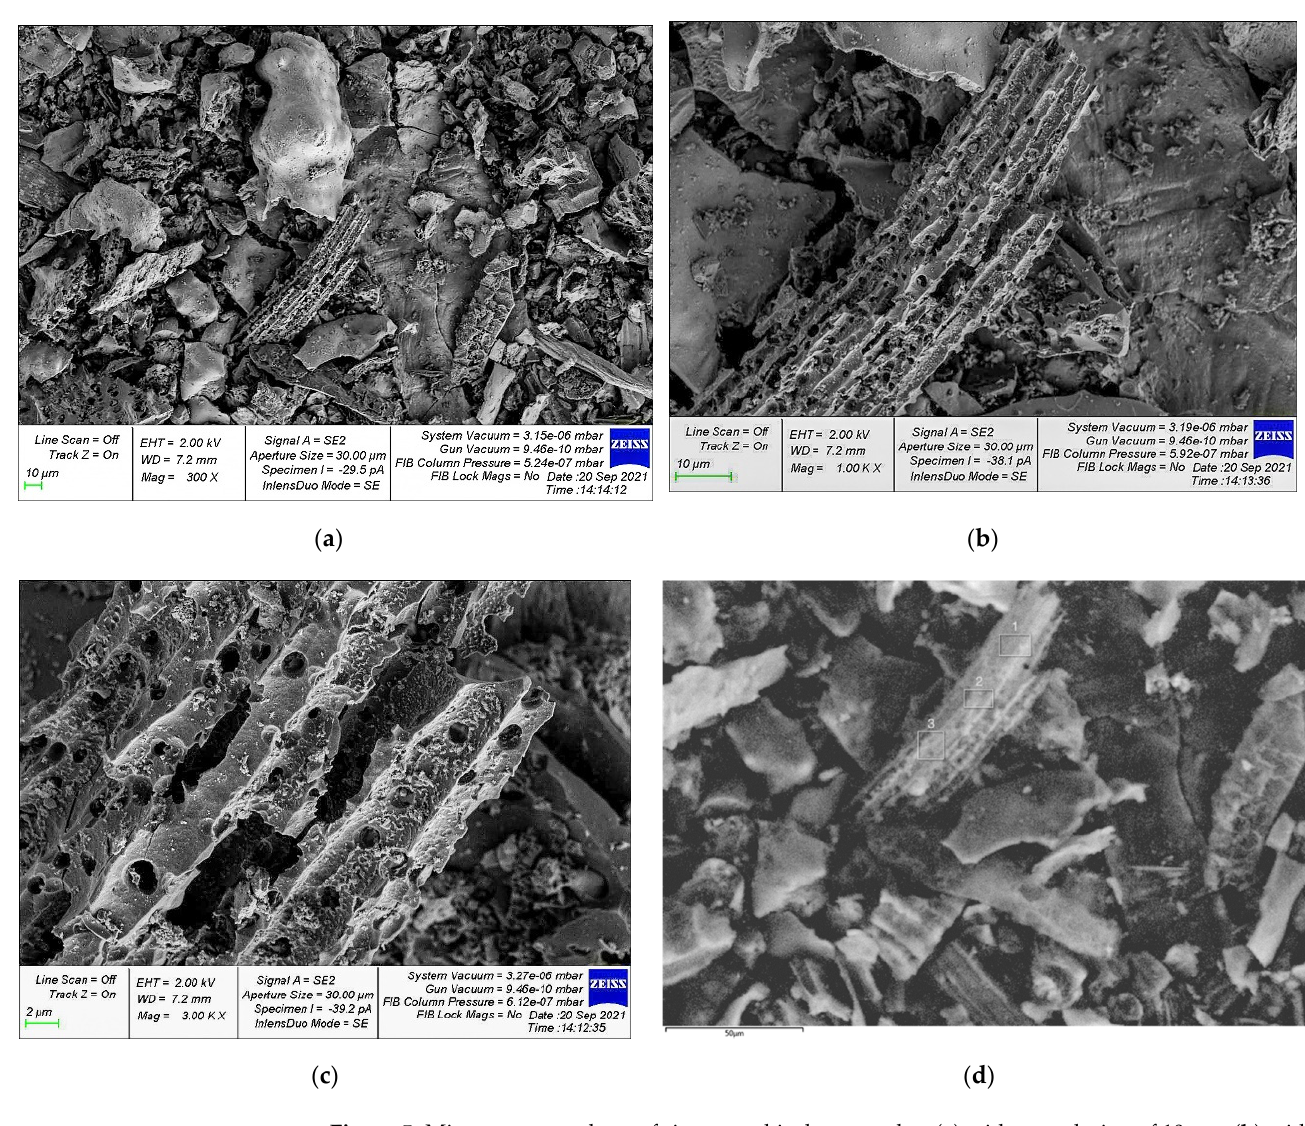
Figure 6. EDX spectrum of rice straw biochar samples.